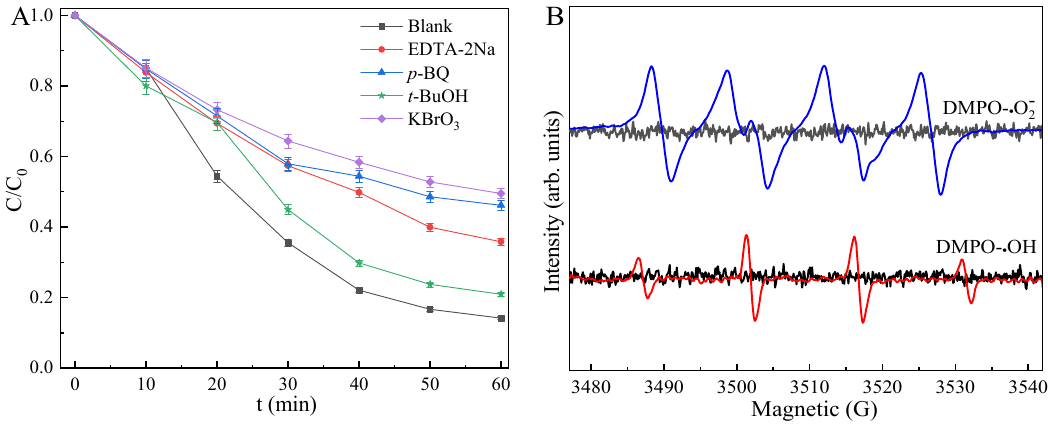
Figure 7. Photocatalytic quenching ( A ) and ESR spectra ( B ) of MnS. The adsorption-photocatalysis mechanism of octahedral MnS was possible due to the sufficient vacant sites of unique octahedral structure and the narrow band gap structure (seen in Figure 8). Considering the zwitterionic and anionic species of TCH at pH > 3.3, TCH molecules were likely to adsorb on the active sites of octahedral MnS at a pH of 3.3~10.75 through the electrostatic attraction [12,61]. In addition, ECB value of MnS treated at 433 K for 16 h ( − 0.58 eV) was more negative than the redox potential value of O 2 /O 2 − ( − 0.33 eV), while the corresponding ECB value (0.79 eV) was less positive than the redox potential value of OH/OH − (1.99 eV). It is indicated that photo-induced e − was favorable for the conversion of dissolved O 2 into O 2 − , but the separated h+ was unsuitable for the reaction of OH − into OH, which was confirmed by the stronger ESR intensity of O 2 − in comparison to OH (Figure 7B) [5,64]. Therefore, MnS with a unique structure such as octahedron was a potential photocatalyst for the efficient degradation of antibiotics from wastewater.